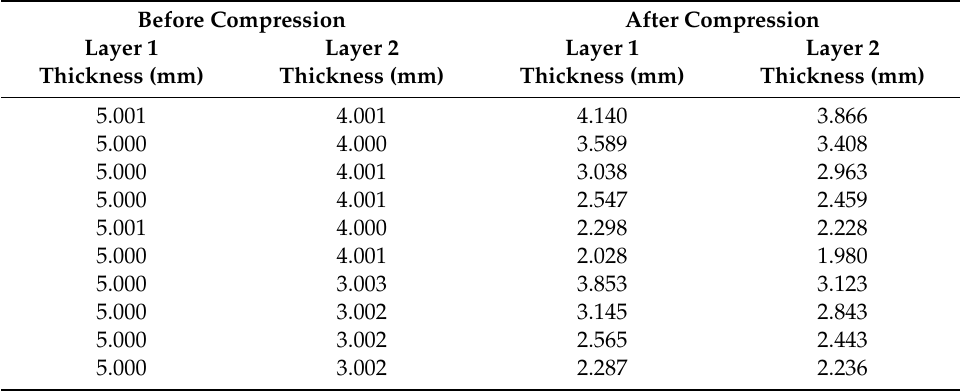
Figure 1. Fabrication process for the three-layer porous material (V 1 : introduction valve, V 2 : exhaust valve, V 3 : exhaust valve, V 4 : metering valve). The first CAPC process was carried out three times to produce layer 1, layer 2, and layer 3 samples; the second CAPC process was carried out once to construct the stacked sample. An optical microscope image of the cross-section of the porous product with three layers is shown in the figure. Table 1. Thickness of each layer for the two-layer compression (Reference